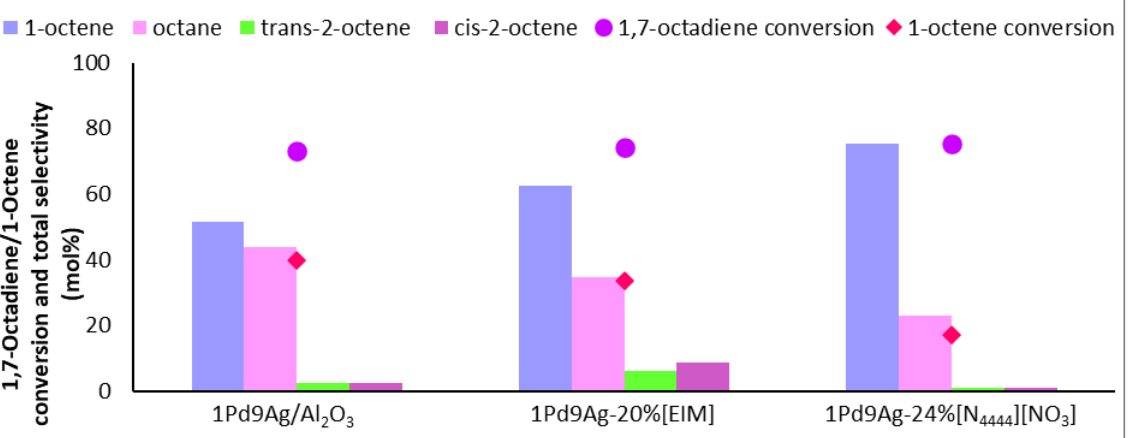
Figure 4. Selectivity profile of 1-octene, internal octenes, and octane over 1Pd9Ag-22%[N 4444 ][NO 3 ]. Reaction conditions: Temperature: 100 °C, Pressure: 30 bar, Diene:H 2 ratio: 1:3.5, LHSV: 9 h −1 , Feed: 2 wt% 1,7 octadiene, 10 wt% octene in hexane.